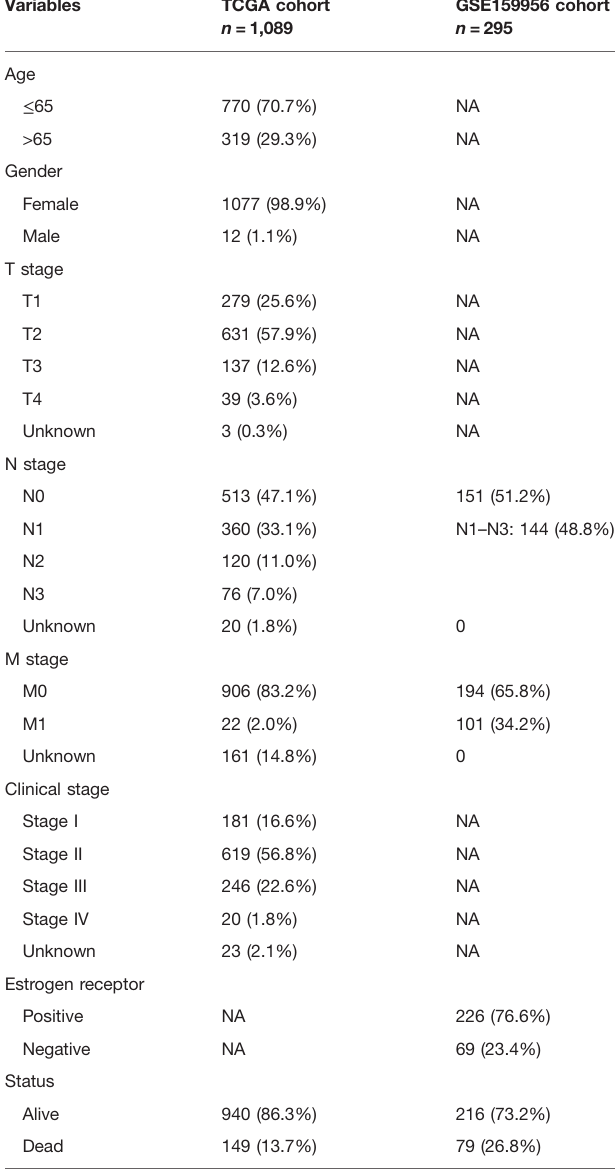
TABLE 1 | Baseline characteristics of BC patients included in this study.